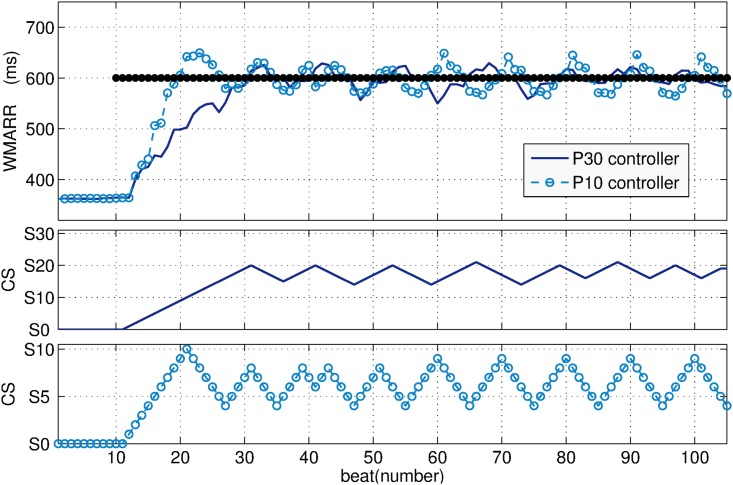
The top of the figure shows the WMARR response when P10 (dotted line) and P30 (solid line) controllers are used to regulate RR to 600 ms. The middle shows the dynamics of the P30. The bottom shows the dynamics of the P10 controller.